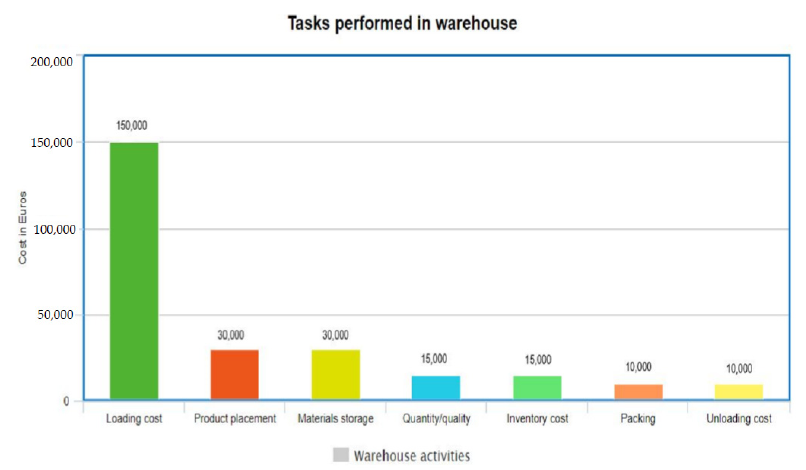
Figure 3. Processes affecting warehouse